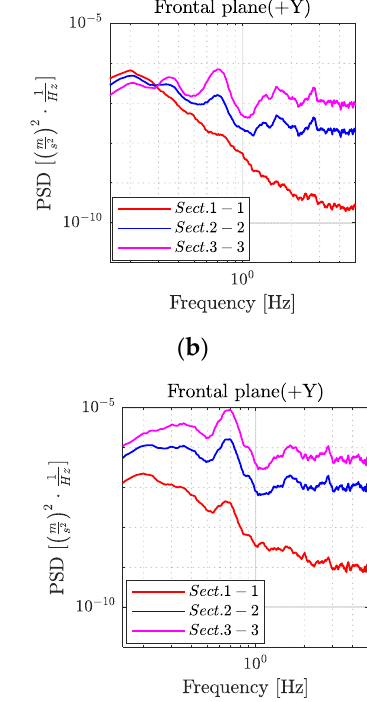
Figure 7. Comparison between the PSDs estimated on the entire signal (black) and the PSDs obtained by averaging the signal (red).